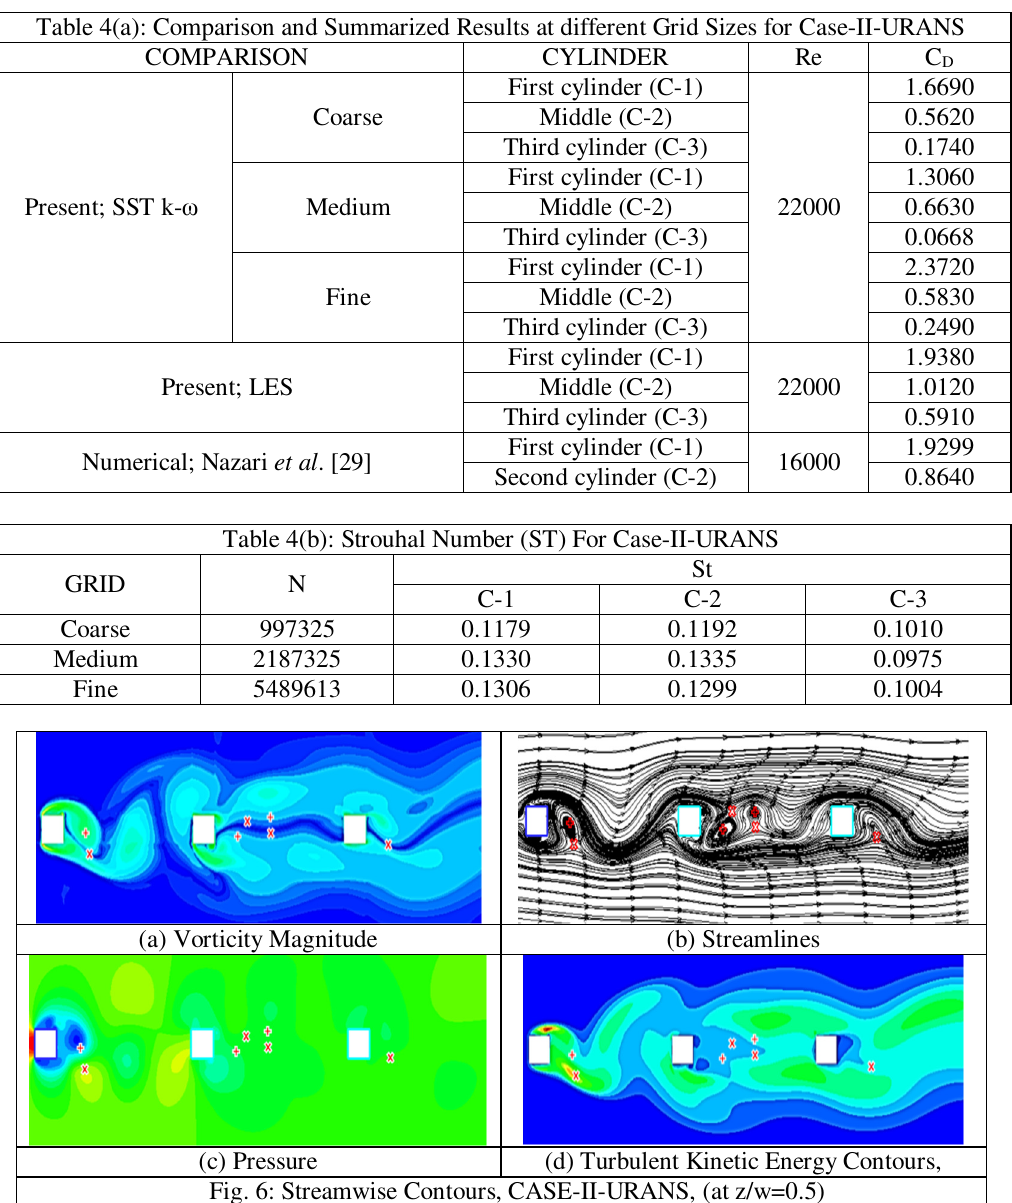
Table 4(a): Comparison and Summarized Results at different Grid Sizes for Case-II-URANS